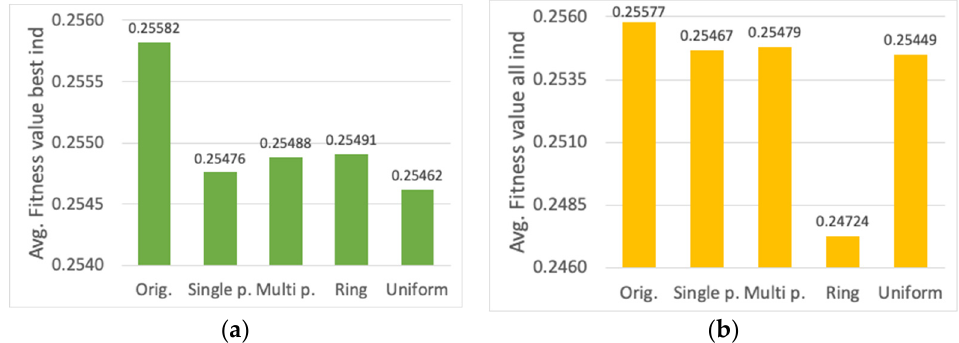
Figure 13. Average fitness value of ( a ) the best individual, ( b ) all the individuals, for different crossover methods.